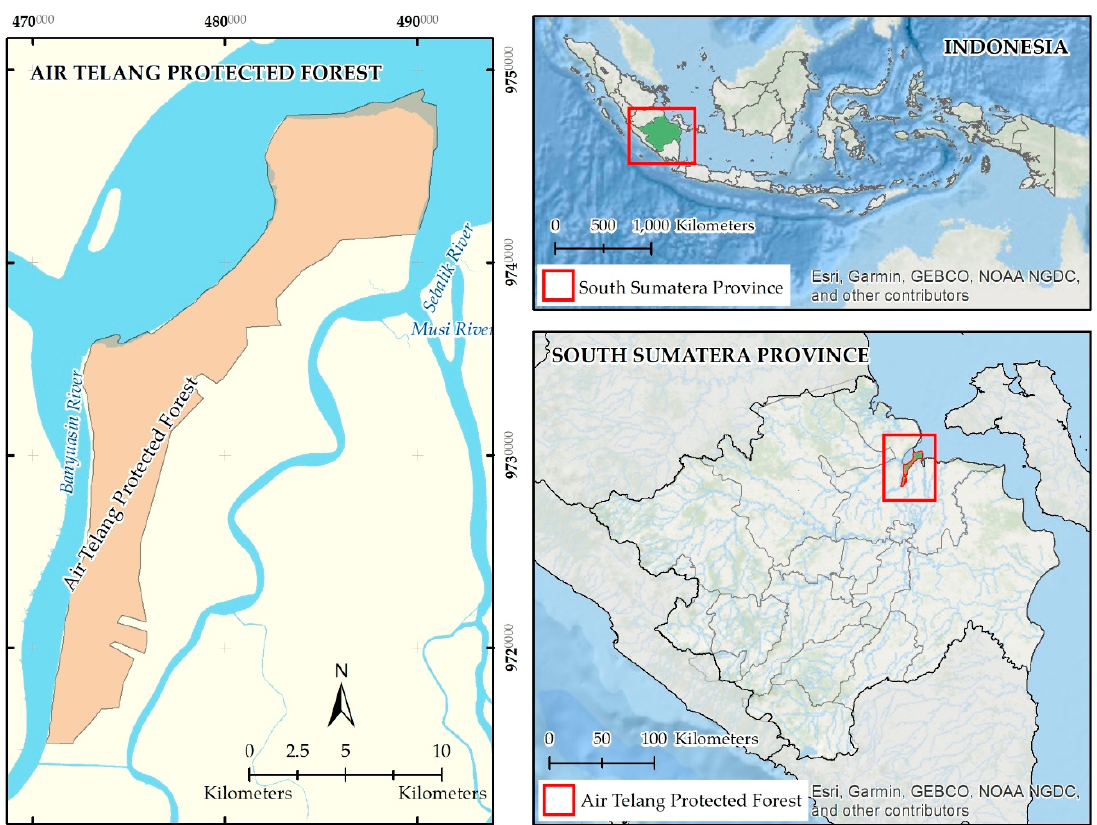
Figure 1. Map of research locations at the Air Telang Protected Forest (ATPF) in South Sumatra Province, Indonesia (red color). Map coordinate system: UTM (Universal Transverse Mercator) projection, zone 48 S, datum WGS (WGS (world geodetic system) 1984.